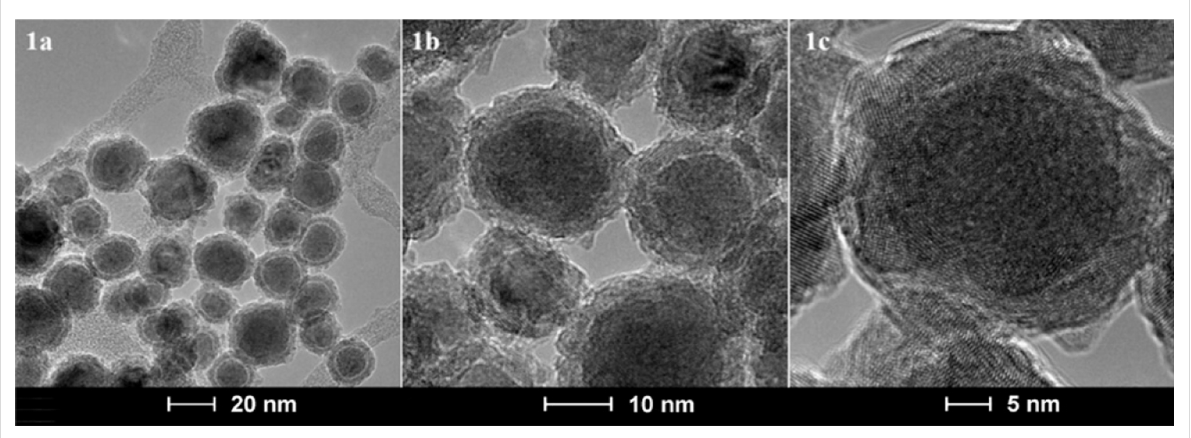
Figure 3: TEM (1a,1b) and HRTEM (1c) images of Fe/Fe 3 O 4 -core/shell nanoparticles that are forming the inorganic core of the nanoplatforms for protease detection, with permission from [20], copyright 2014 Royal Society of Chemistry. HRTEM images revealed that the Fe(0) centers are mostly crystalline